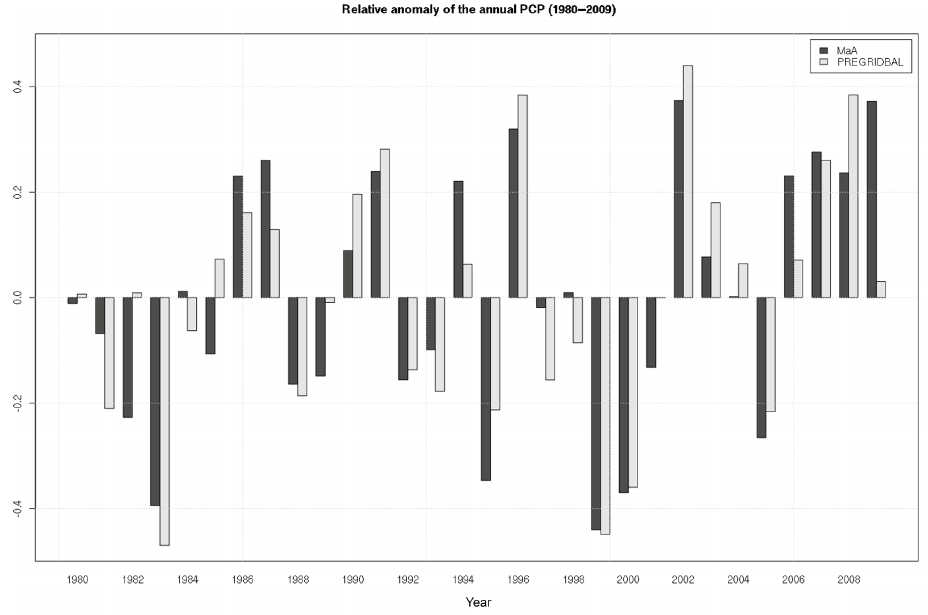
Figure 4. Time series of the relative annual precipitation anomalies at the Mallorca airport and for Mallorca as a whole derived from the PREGRIDBAL